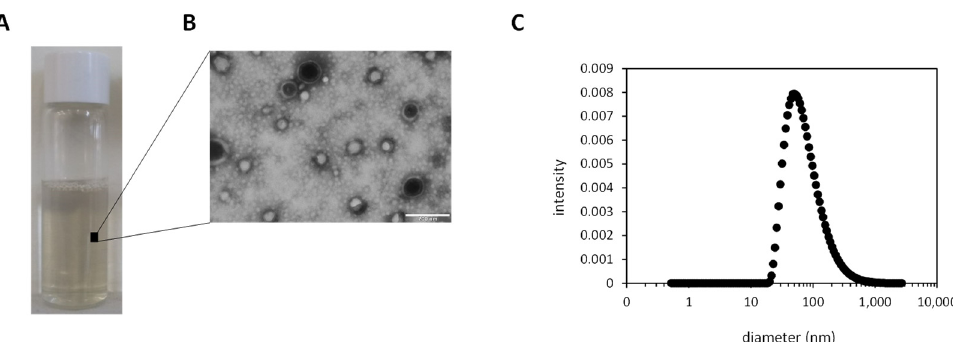
Figure 3. ( A ): Physical appearance of RA-loaded PLGA_PC NPs after 1 h incubation. PLGA polymeric NPs were centrifuged and resuspended in 1 × PBS; ( B ): TEM microscopy image of RA-loaded PLGA_PC NPs showing the spherical morphology of PC NPs. Scale bar = 200 nm; ( C ): DLS size distribution of RA-loaded PLGA_PC NPs after 1 h incubation. Table 2. Biophysical characterization of the pre-formed protein corona (PC) adsorbed on the surface of PLGA polymeric NPs 1 .